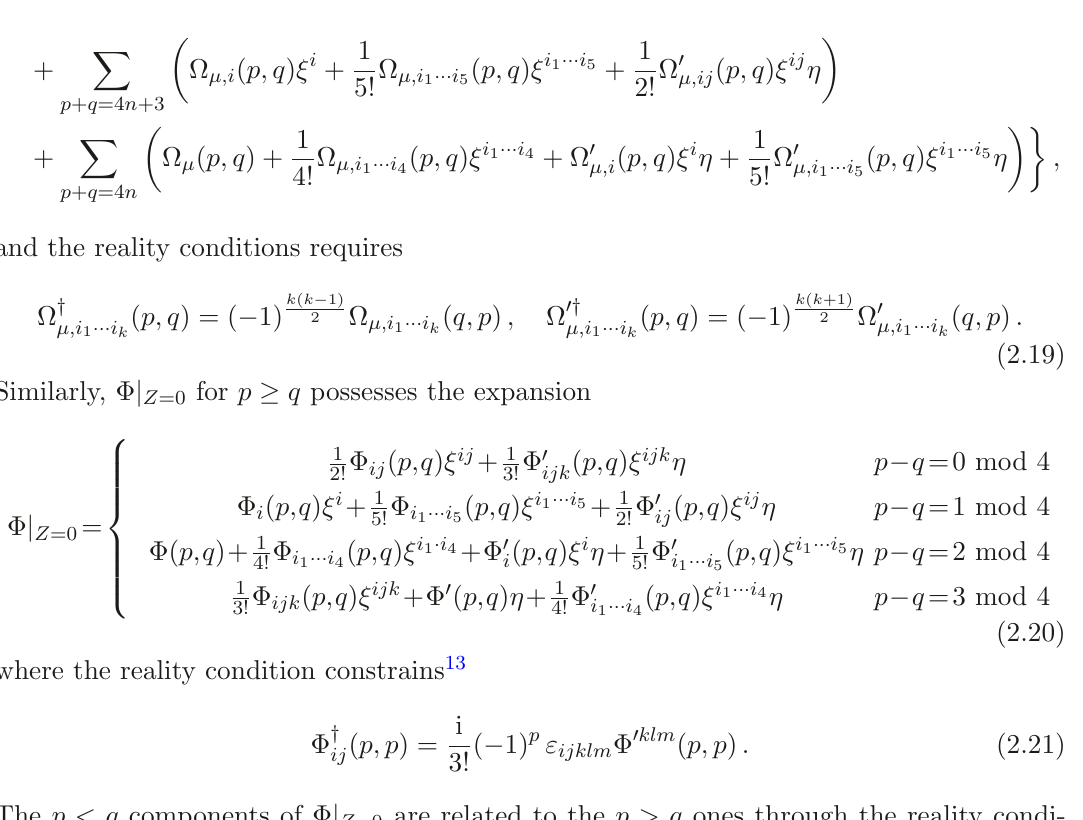
Table 1 . The spectrum of physical fields carrying symmetric in the = 5 Vasiliev theory with M N the O ( N ) internal symmetry in the language of SO(5) representations. For s 1 fields, the level ℓ ≥ is related to s by s = 2 ℓ + 2 k/ 2 + r/ 2 where k is the number of ξ s and r is the number of η . The − values of ℓ are assigned to spin-0, 1/2 fields such that fields belonging to the same supermultiplet are labeled by the same ℓ . The underlines denote the fields in the = 5 SUGRA multiplet. This N table also provides the spectrum of physical fields associated with antisymmetric in the case J M with USp(2 N ) internal